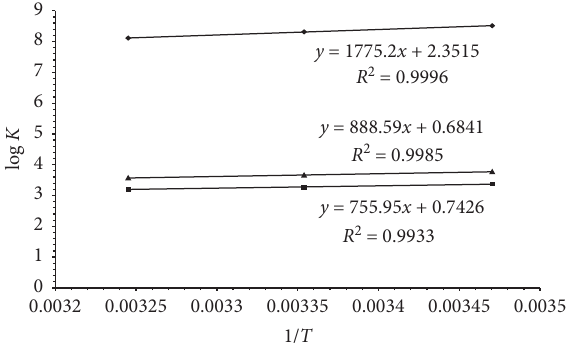
Figure 9: Effect of temperature on the protonation constant of DMPTHP. Table 8: Thermodynamic parameters for the protonation of the ligand (DMPTHP) in 50% DMSO-H NaNO 3 .